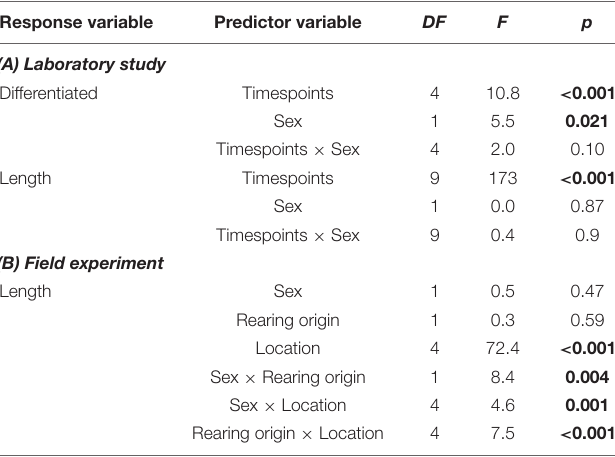
TABLE 2 | Summary table of the statistical analyses for both the laboratory and field experiments, conducting analysis of variance on linear regression models. Response variable